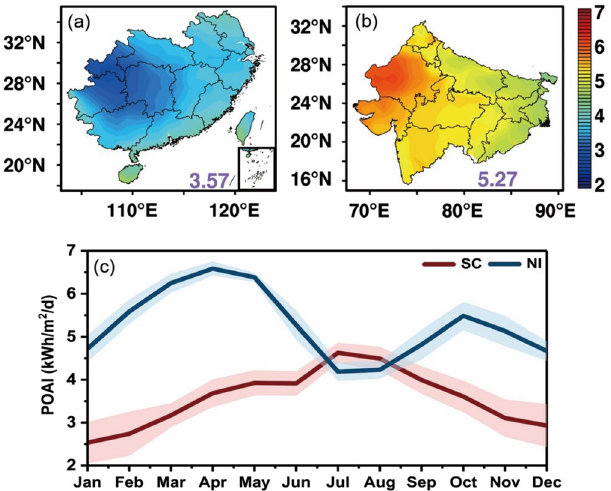
Figure 2. The annual averaged POAI over ( a ) the SC and ( b ) the NI under the all-sky condition from 2003 to 2019 (unit: kWh/m 2 /d). The numbers represent the values of regional averaged POAI; ( c ) the monthly averaged POAI over the SC and NI. The color shadings denote the standard deviations of POAI. The map was generated by ESRI ArcGIS 10.5 software available at the ESRI website (https:// www. esri. com/ en- us/ arcgis/ produ cts/ arcgis- platf orm/ overv iew). The administrative boundary shapefile for southern China is available at the RESDC website (https:// www. resdc. cn/) and the administrative boundary shapefile for northern India is available at the GADM website (https:// gadm. org/ downl oad_ count ry.